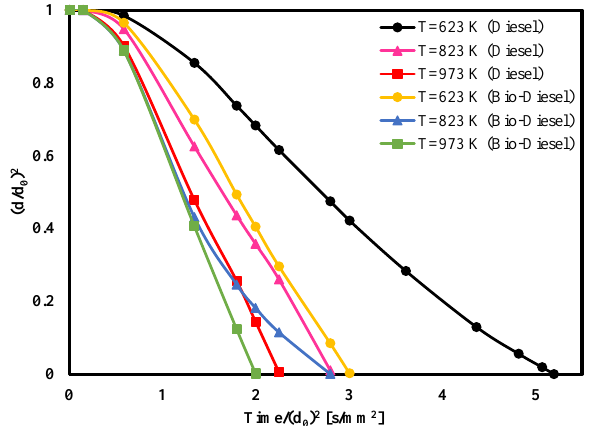
Figure 5. Variation of 25-micron droplet’s dimensionless diameter at various ambient temperatures.